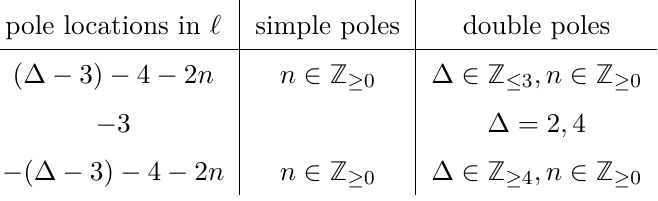
Table 2. Simple and double poles of Γ(∆ − 3)